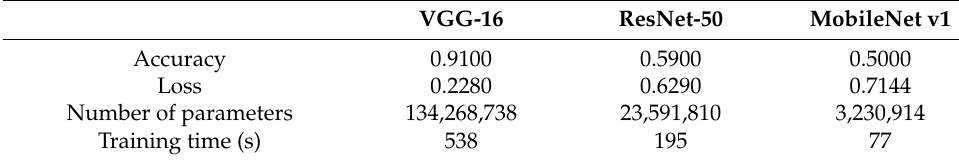
Table 4. Results of Experiment 1.